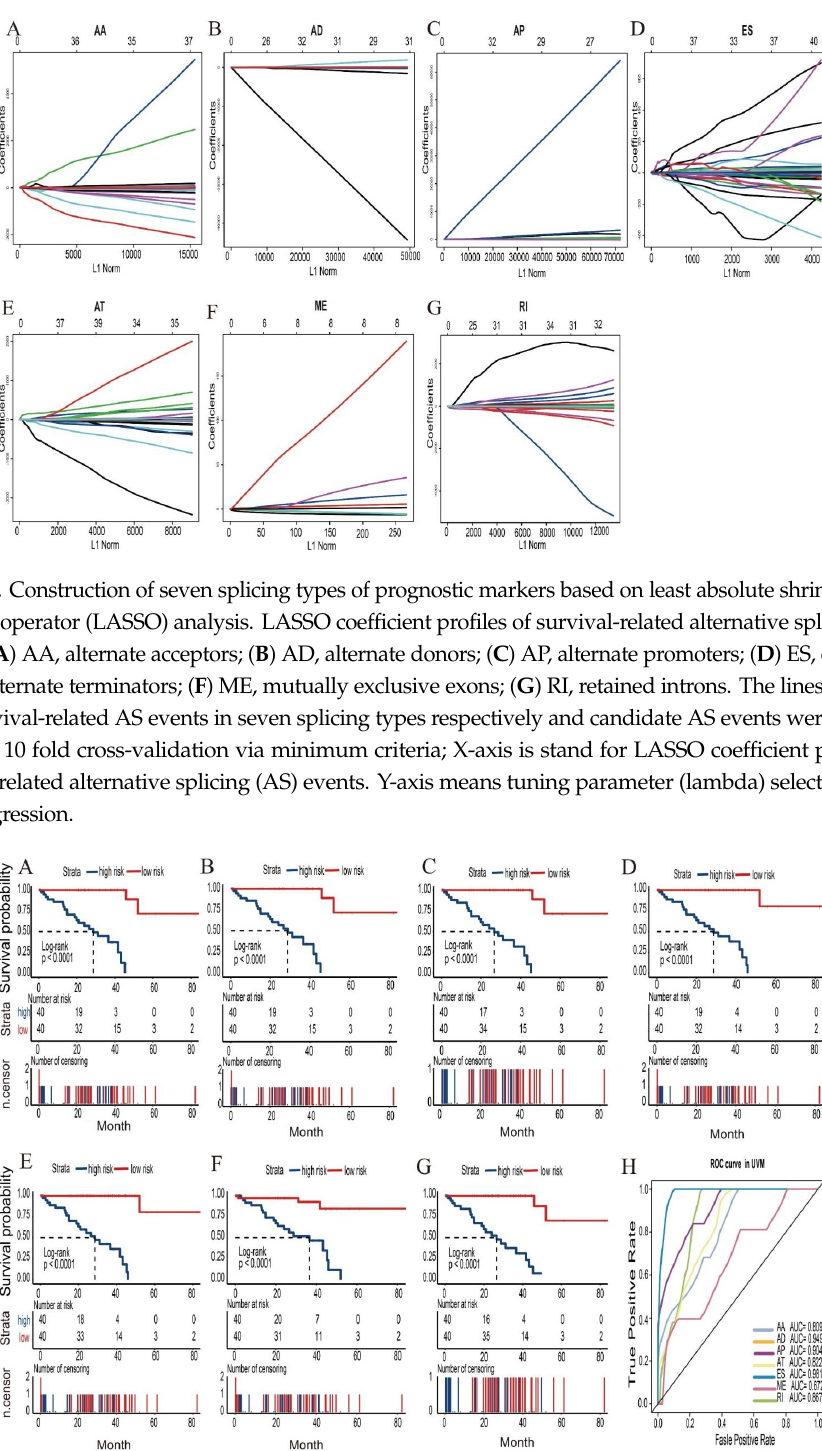
Figure 5. Kaplan–Meier plots and receiver operating characteristic (ROC) curves of predictive factors in UM cohort. ( A – G ) Kaplan–Meier curves of prognostic models built with alternative splicing (AS) events of alternate acceptor (AA), alternate donor (AD), alternate promoter (AP), alternate terminator (AT), exon skip (ES), retained intron (RI), and mutually exclusive exon (ME) splicing types for patients with UM. Time-dependent numbers at risk are listed at the middle panels and the number of censor patients are listed at the bottom panels. ( H ) The ROC curves of predictive models for each splicing type in UM.